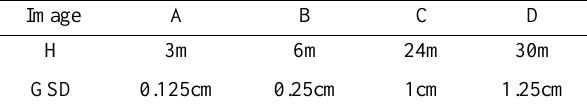
Table 3. GSD calculation for four images